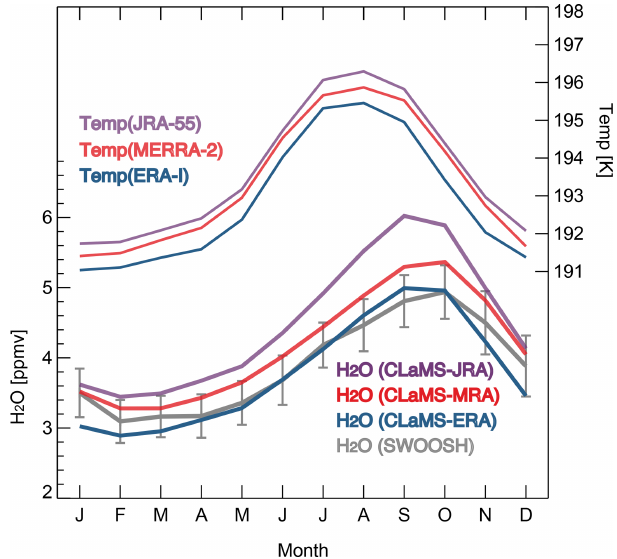
Figure 4. Relationships between tropical tropopause temperatures and water vapor entry mixing ratios (mean H 2 O mixing ratios on θ = 400K averaged over 20 ◦ S–20 ◦ N). Here tropical tropopause temperatures refer to the minimum in the mean temperature profile within the tropics (20 ◦ S–20 ◦ N) between θ = 360 and 420K. The upper set of lines shows the climatological annual cycles for tropical tropopause temperatures, while the lower set of lines shows the cli- matological annual cycles for water vapor entry mixing ratios. Note that the model results of annual cycles is based on “CLaMS pe- riod” (1980–2013), which is longer than “SWOOSH period” start- ing around